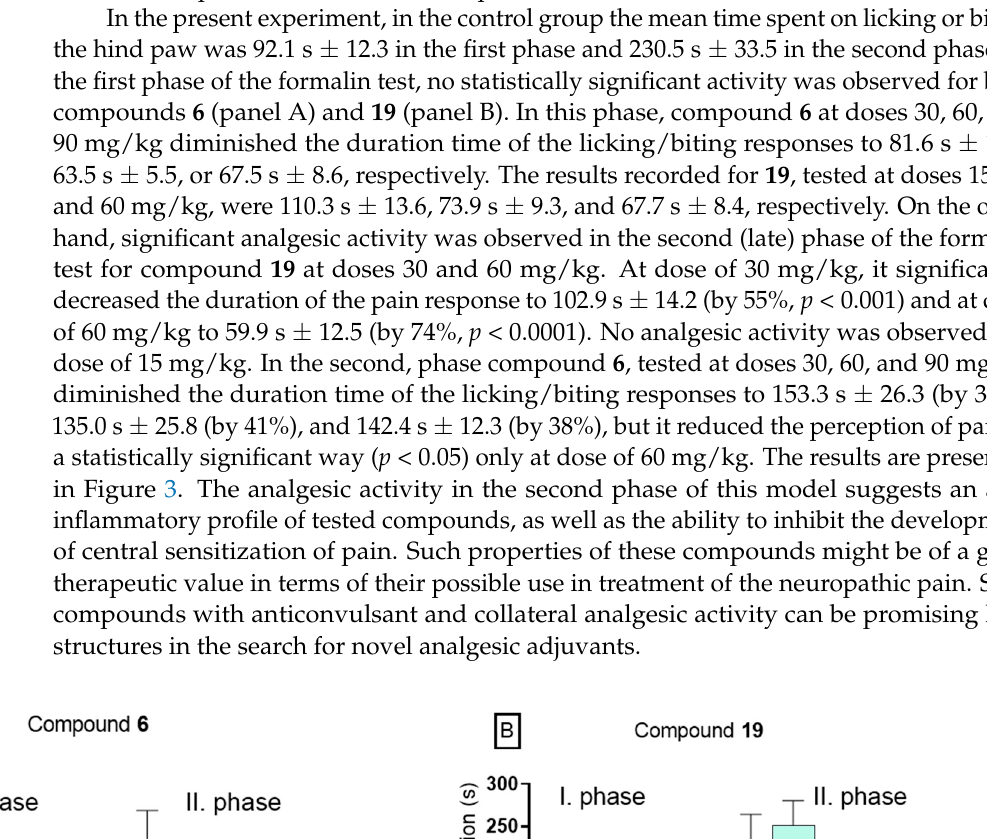
Table 4. In vitro binding assays (concentration 100 μ M).